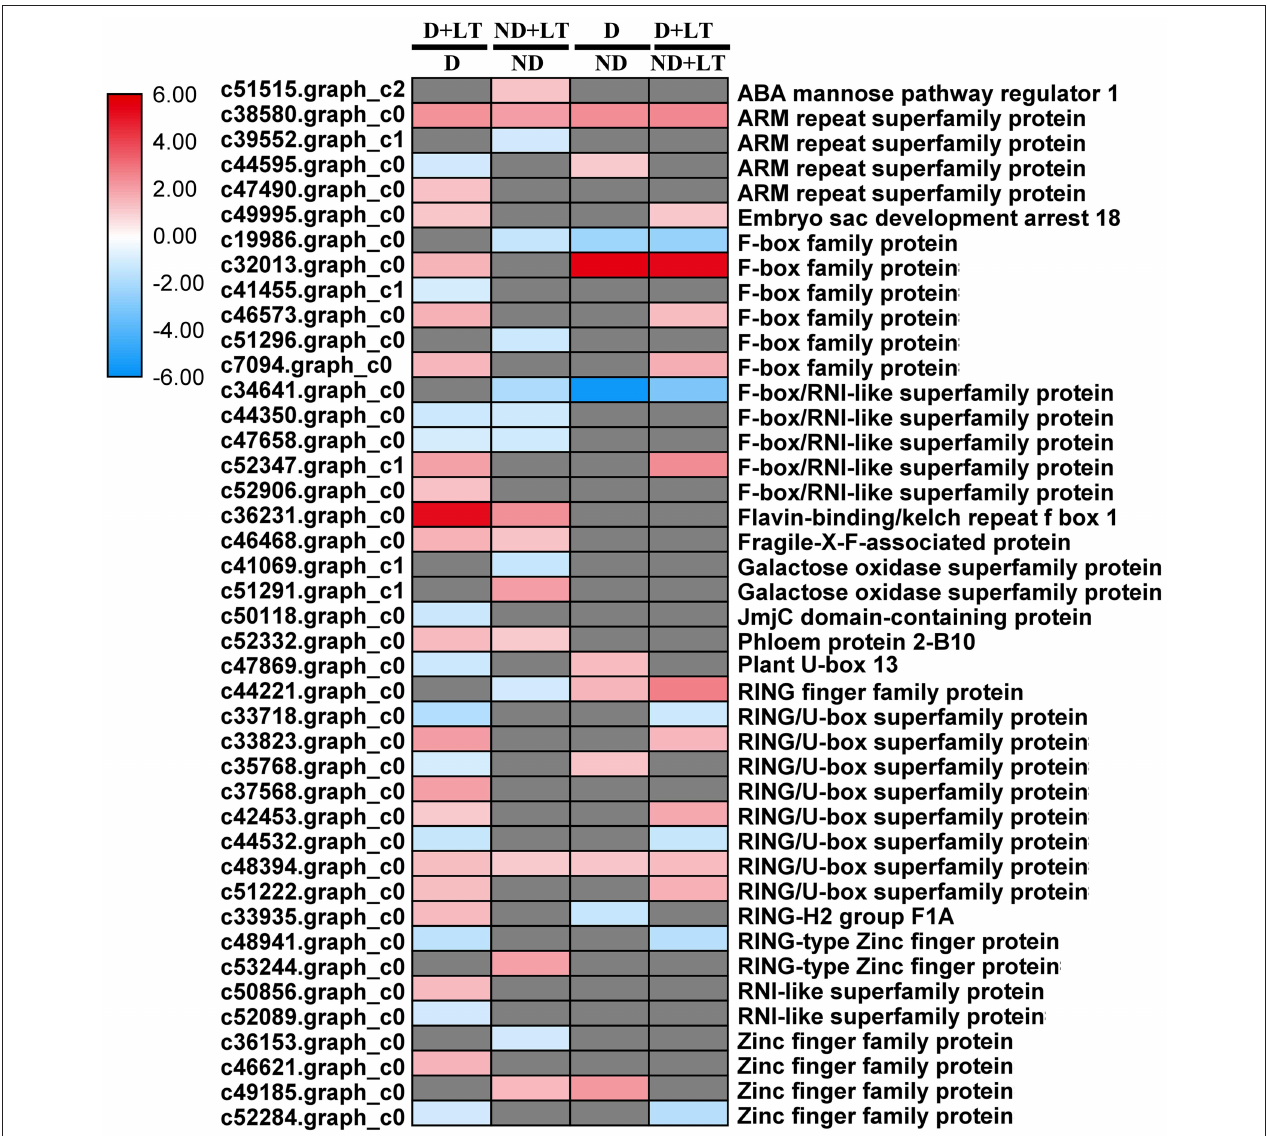
FIGURE 7 | Transcript profiles of the ubiquitin-dependent degradation genes in different dormancy varieties of alfalfa under LT. The color scale indicates log 2 -transformed fold changes in expression levels between dormancy (D) and non-dormancy (ND) genotype under normal growth condition or LT condition. Red, blue, and gray denote upregulation, downregulation, and no change in expression, respectively.